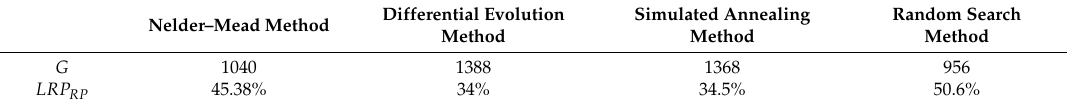
Table 10. Comparative financial losses using different computational methods for returned products.